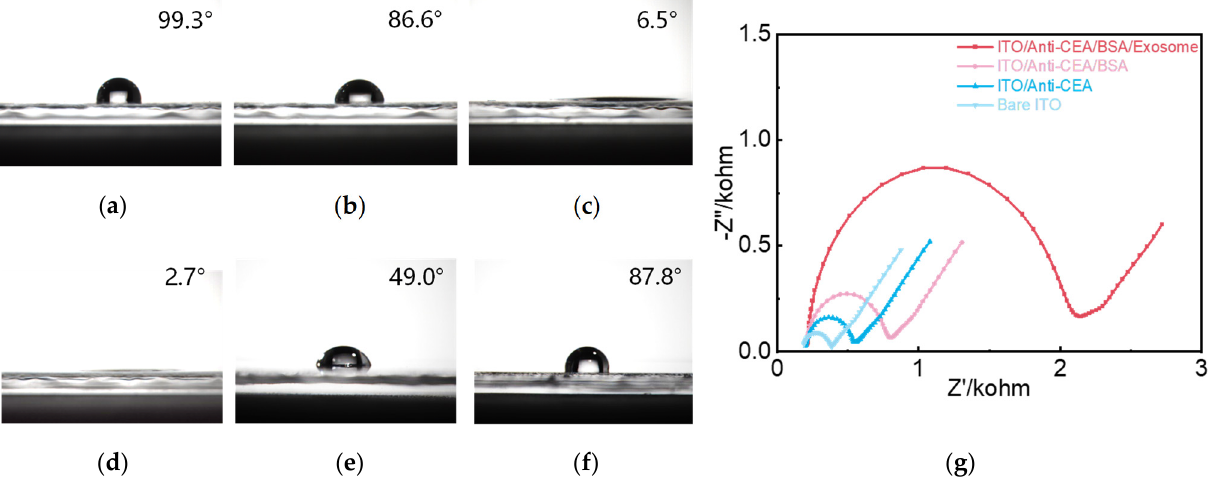
Figure 4. Characterization of the modification process of designed immunosensor. Water contact angle on working electrode ( a ) before cleaning, ( b ) after cleaning, ( c ) after hydroxylation, ( d ) after amination, ( e ) after aldehyde, and ( f ) after anti-CEA immobilization; ( g ) electrochemical impendence spectra of the stepwise modification of ITO/anti-CEA/BSA/exosome (frequency range 0.1 to 10 kHz).